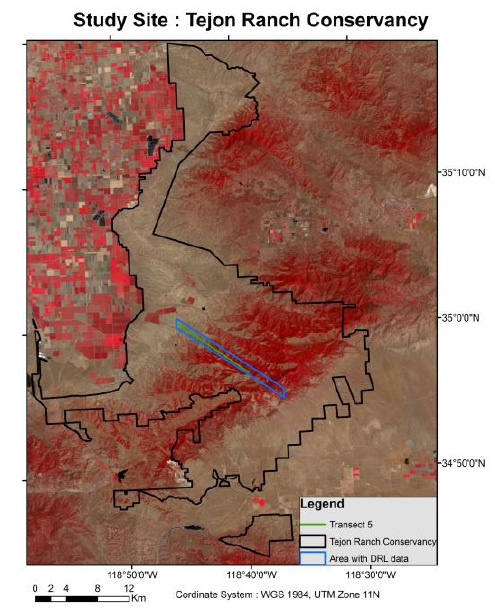
Figure 1. Map showing Landsat TM false color (432) image of study area and location of DRL data extent and transect